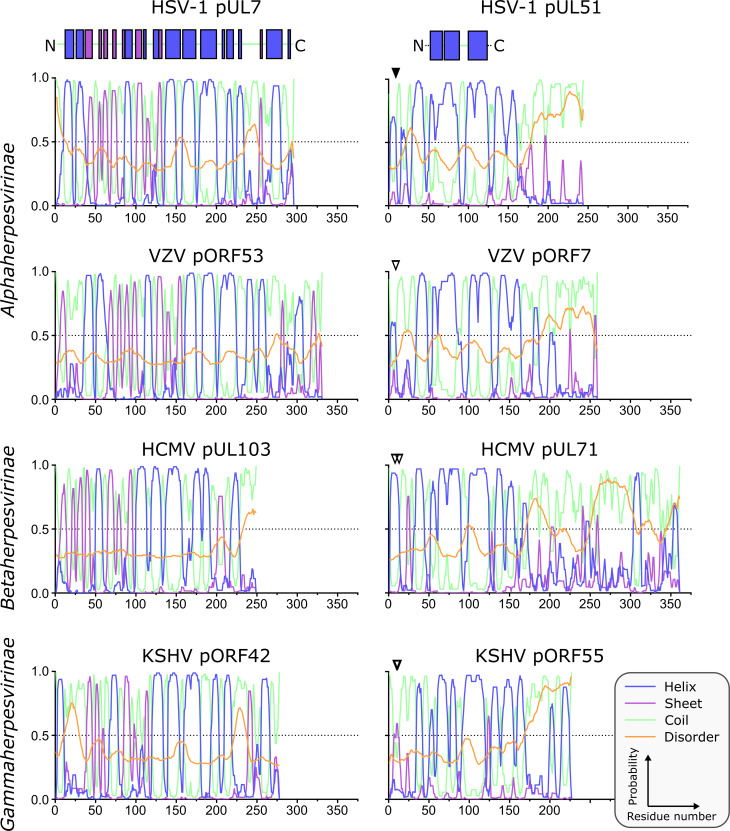
Predicted secondary structure of pUL7 and pUL51 homologues from representative human α-, β- and γ-herpesviruses.Analyses of amino acid sequences were performed as described in Materials and Methods. Per-residue probabilities of forming α-helix (blue), β-sheet (purple) or coil (green) are shown, as is the probability of disorder (orange). Residues that are known (solid triangles) or predicted (empty triangles) to be palmitoylated are marked: Cys9 of HSV-1 pUL51, Cys9 of VZV pORF7, Cys8 and Cys13 of HCMV pUL71, Cys10 and Cys11 of KSHV pORF55. Regions of pUL7 and pUL51 α-helix and β-sheet observed in the pUL7:pUL51(8–142) core heterodimer structure are shown above the predictions as boxes. The predicted pUL7 and pUL51 secondary structural elements are largely conserved across herpesvirus families, although the first two helices of pUL7 are not conserved in β-herpesviruses like HCMV. Additionally, the C-terminal regions of pUL51 homologues vary in length, although in all herpesvirus families they are predicted to be largely unstructured.